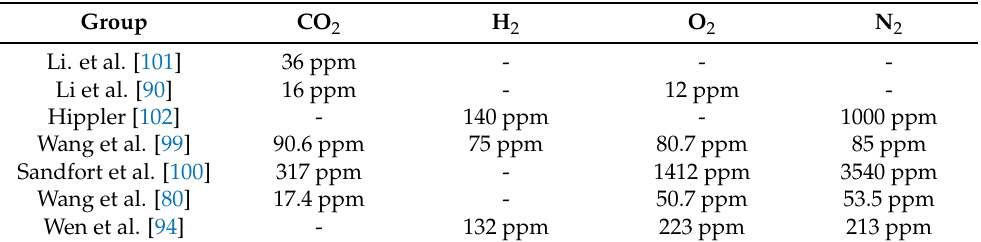
Table 5. Most common analytes and their limit of detection (LOD) of different CERS setups. Group